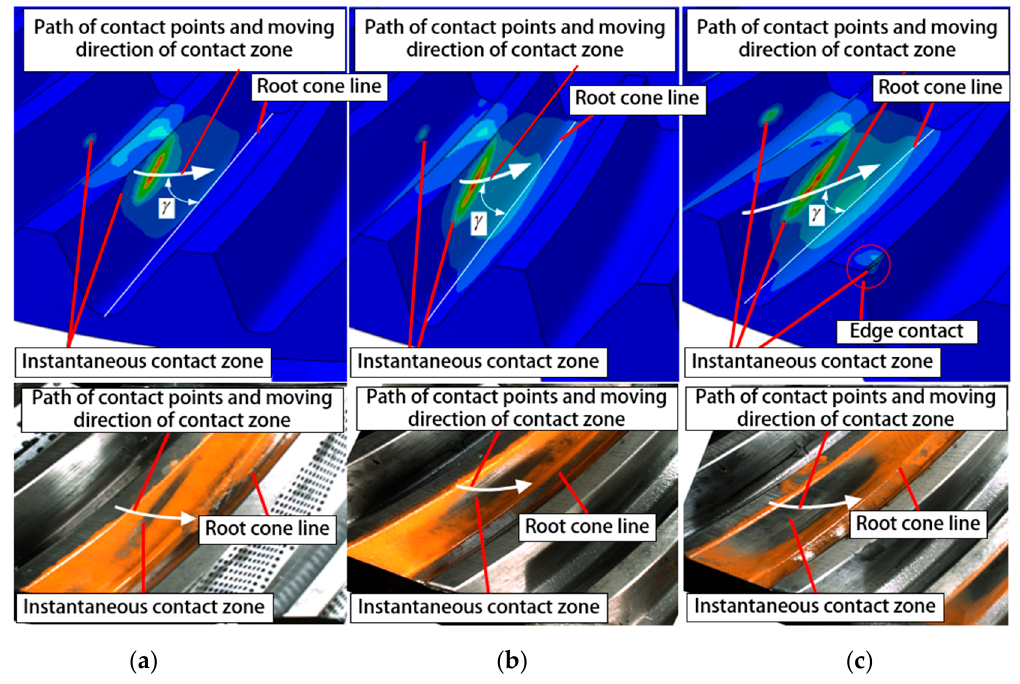
Figure 15. Composition of test bench.